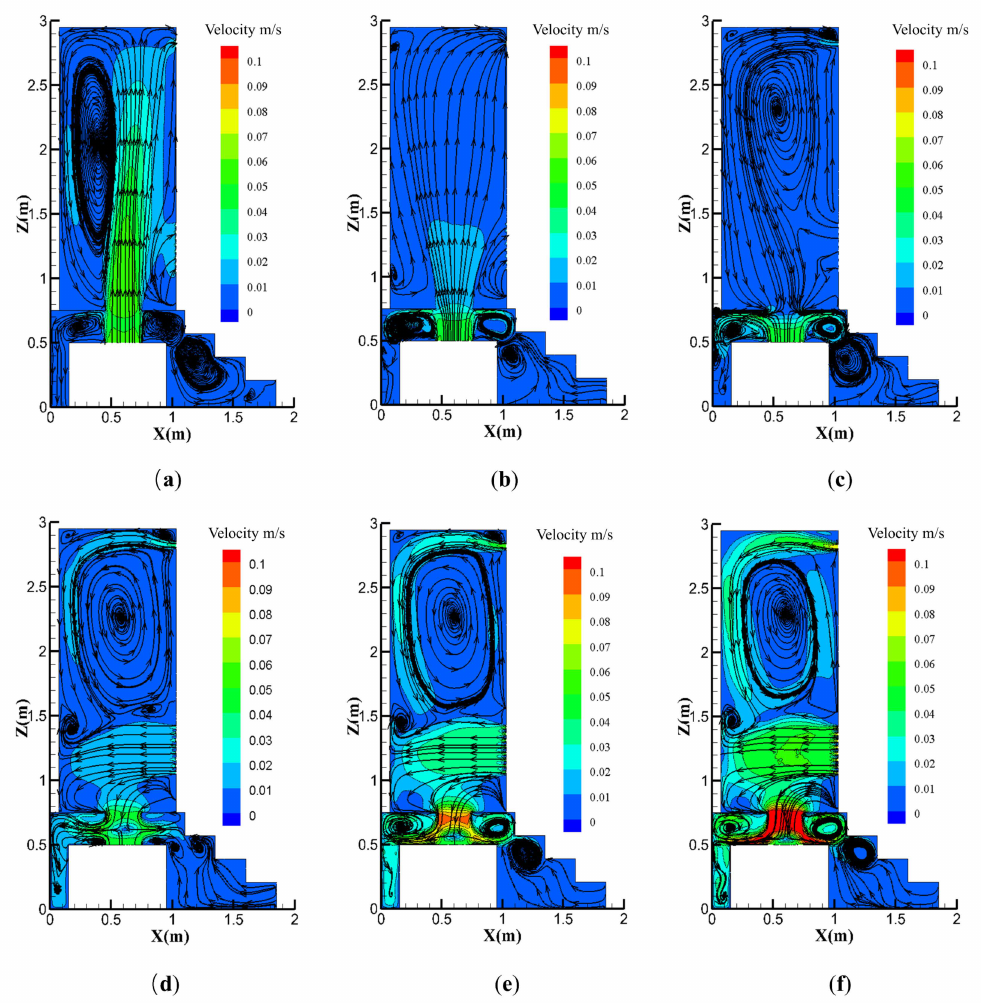
Figure 14. Ammonia diffusion dynamics for different ACH (unit: h − 1 ) values (EFP-F 1 ). ( a ): ACH = 0; ( b ): ACH = 2; ( c ): ACH = 4; ( d ): ACH = 6; ( e ): ACH = 8; ( f ): ACH =